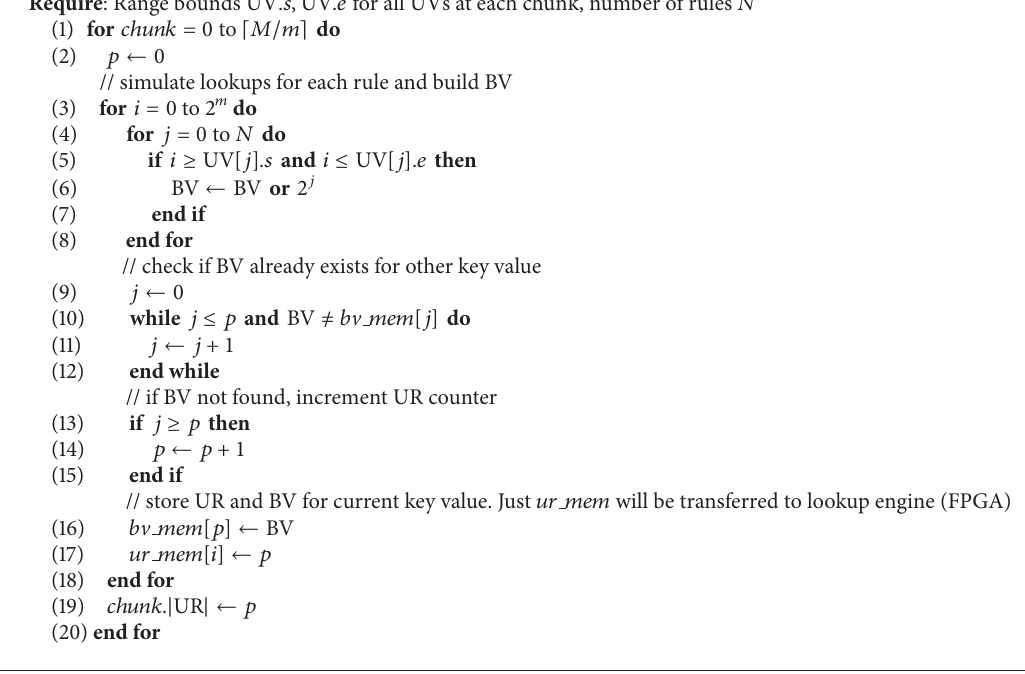
Algorithm 1: Ruleset population algorithm for IND.